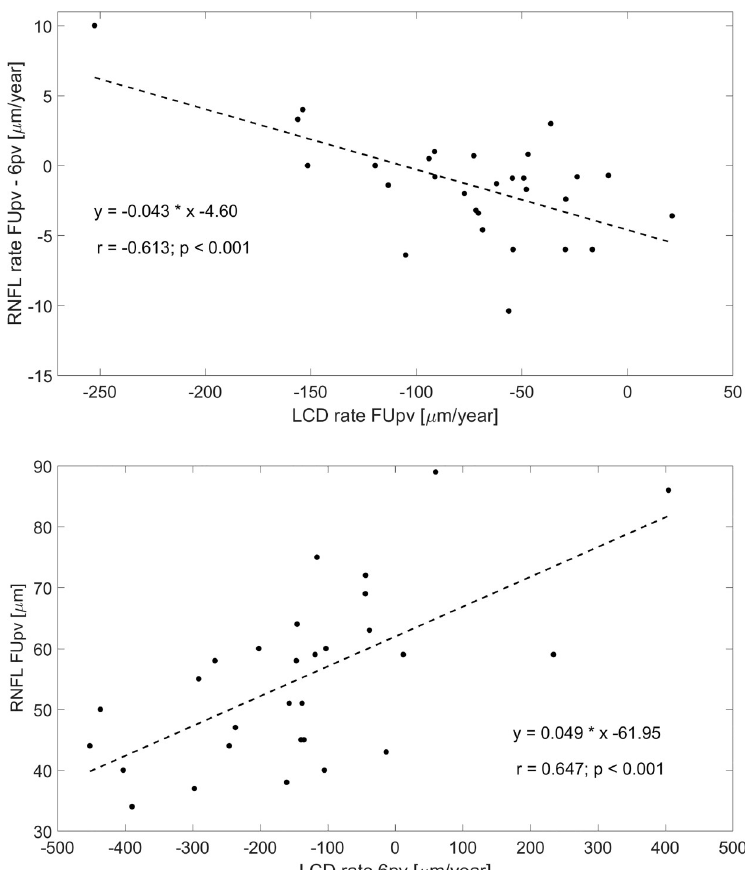
Fig 4. Correlations between RNFL rate at FUpv–6pv and LCD rate at FUpv (top plot) and between RNFL FUpv and LCD rate at 6pv (bottom plot).